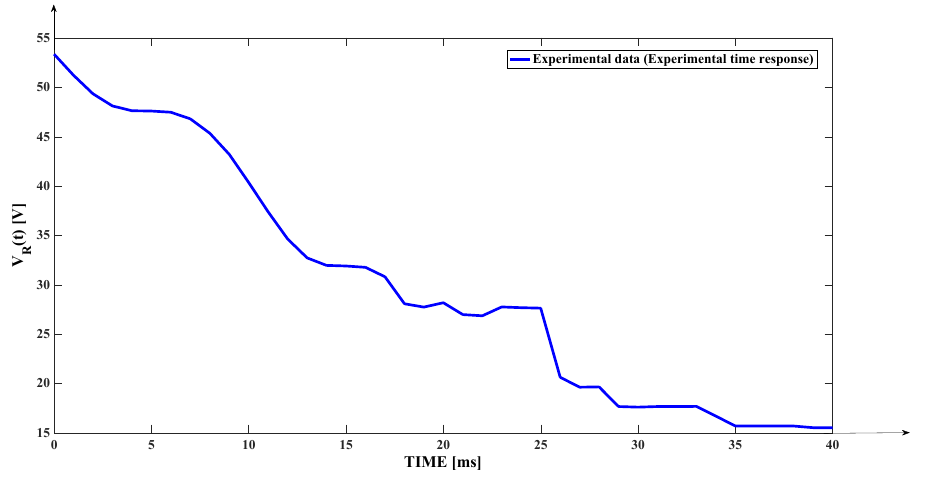
Figure 12. Experimental time response (persistent fault).